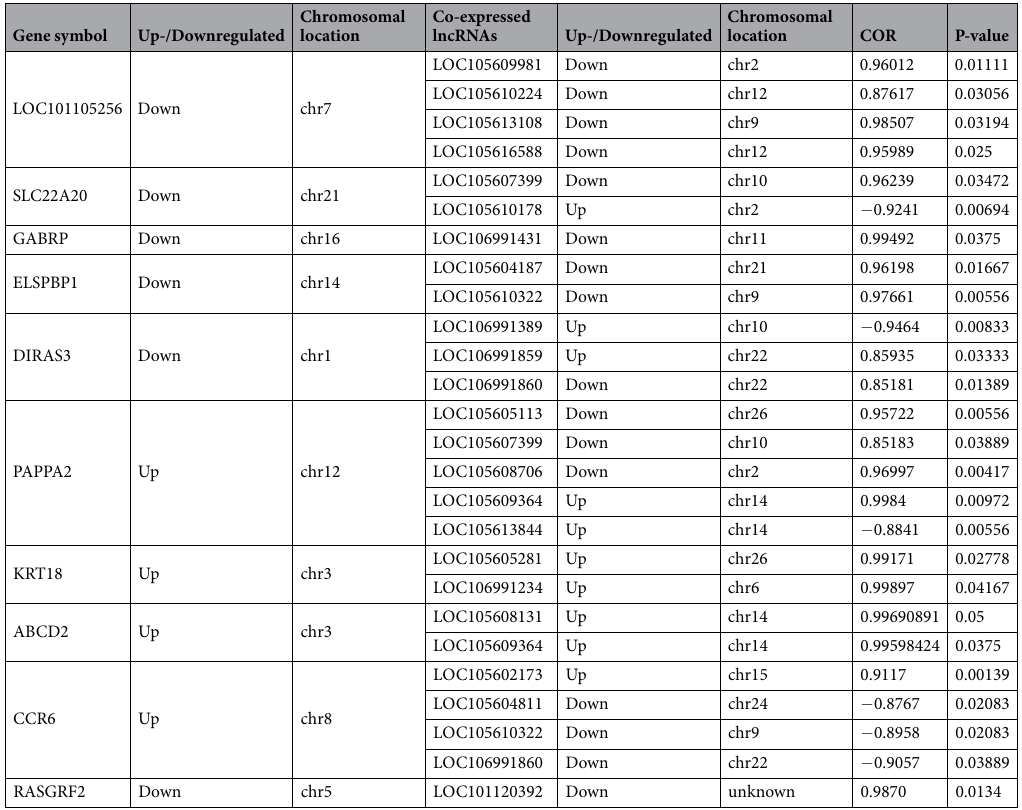
Table 3. Reproduction-related genes and their co-expressed lncRNAs.